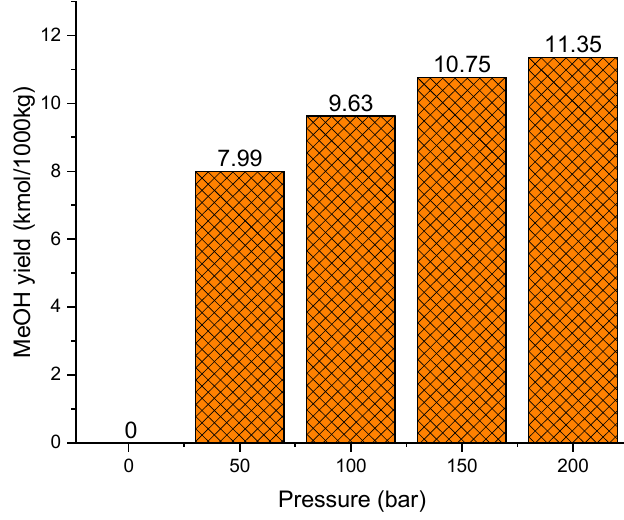
Figure 11. E ff ect of pressure on methanol yield (250 ◦ Figure 11. Effect of pressure on methanol yield (250 °C).